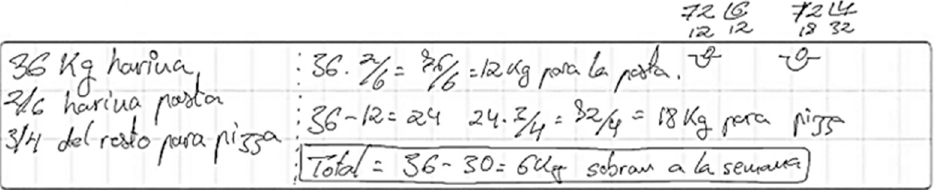
Figure 6. PT1’s written answer to problem FWP3. (Translation of PT1’s solution: “12 kg for pasta. 18 kg for pizza. Solution: 6 kg a week left over.”).